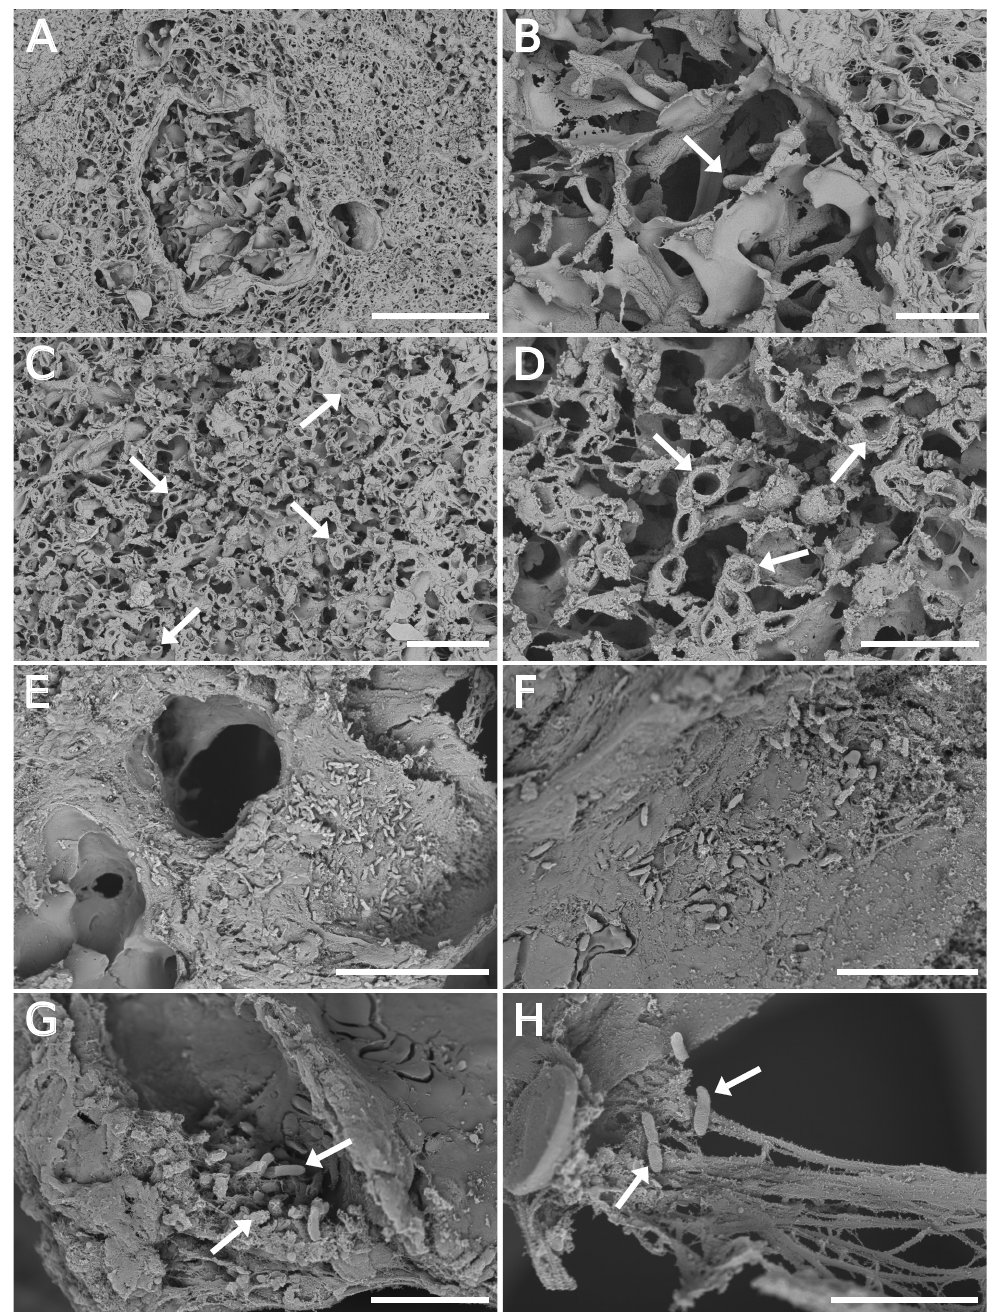
CycloBranch software using the TIFF file metadata. The two squares indicated in Figure 4D illustrate the 50 µm × 50 µm area irradiated by the laser beam containing the rod-shaped bacterial cells.